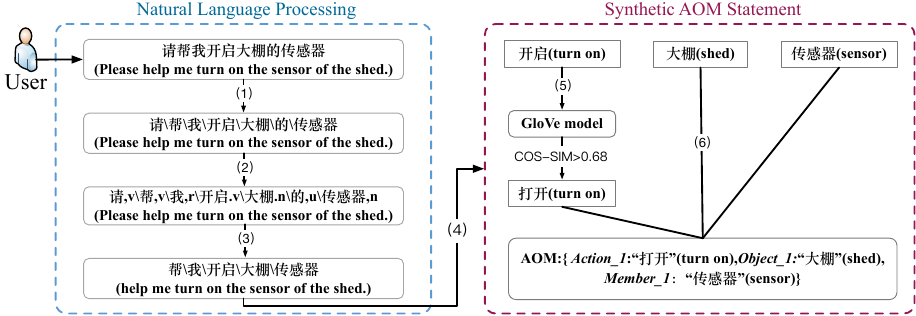
Figure 3. Workflow for the extraction of basic natural language